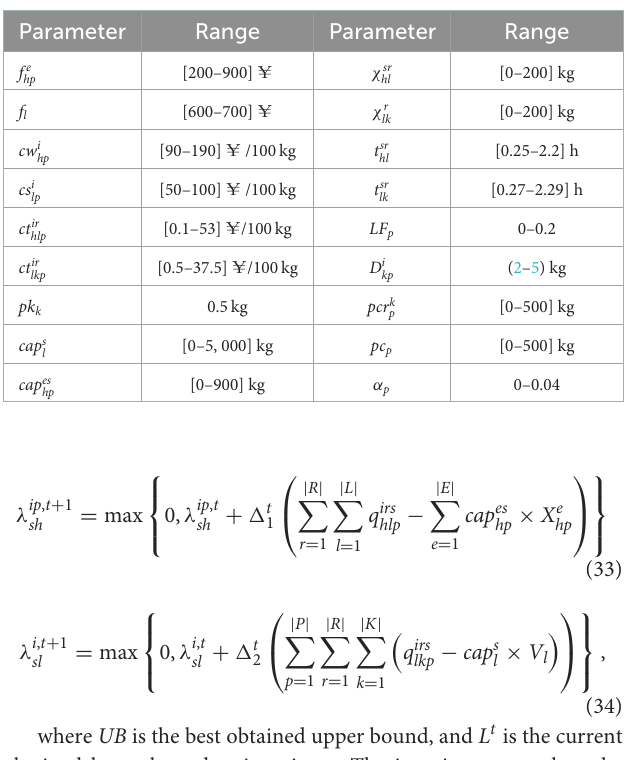
TABLE 2 The ranges of the